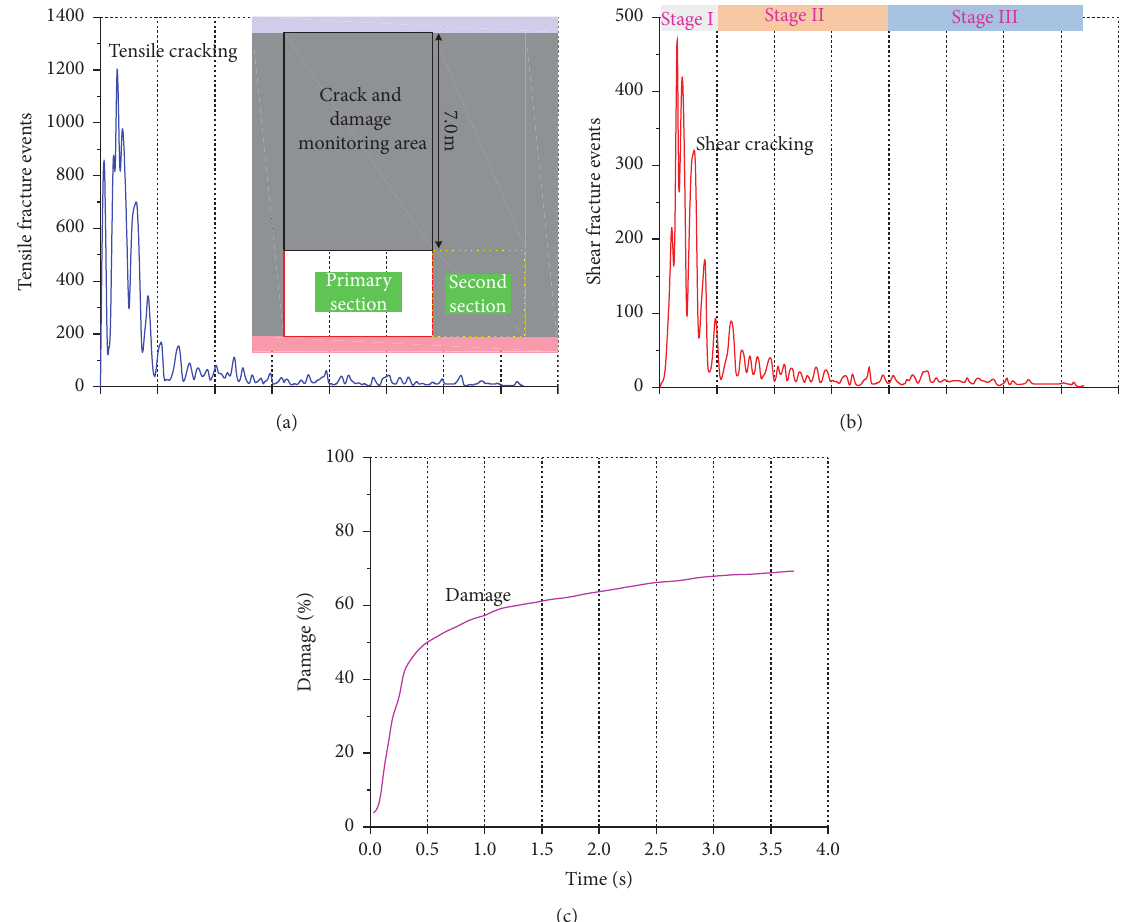
Figure 9: The change law of microcrack events and damage amount in the roof area after the primary section